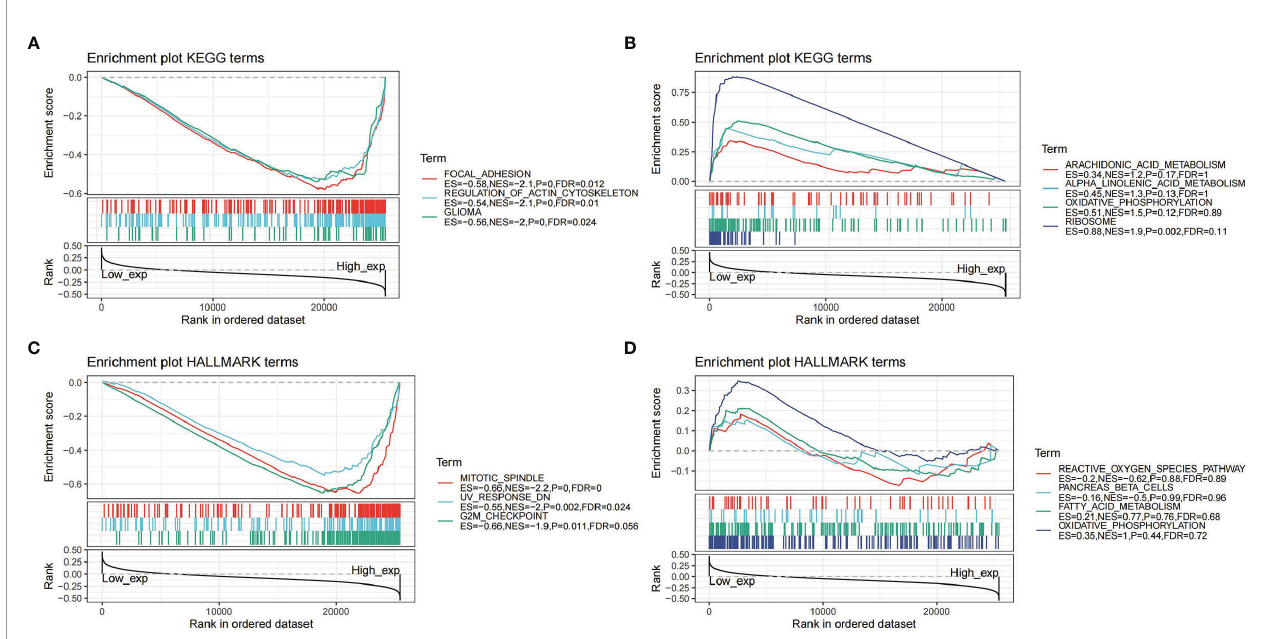
FIGURE 9 | Gene set enrichment analysis in pan-cancer. (A) Enrichment plot of KEGG terms in high expression of CDK6. (B) Enrichment plot of KEGG terms in low expression of CDK6. (C) Enrichment plot of Hallmark terms in high expression of CDK6. (D) Enrichment plot of Hallmark terms in low expression of